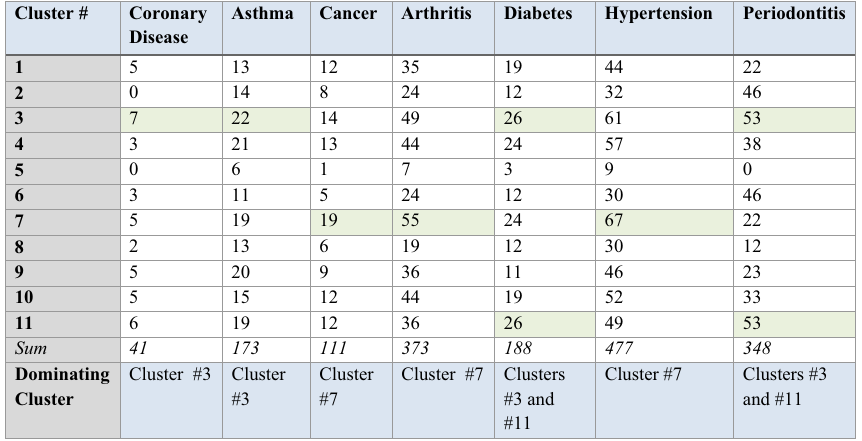
Table 3 Chronic diseases’ distribution amongst clusters Cluster # Coronary